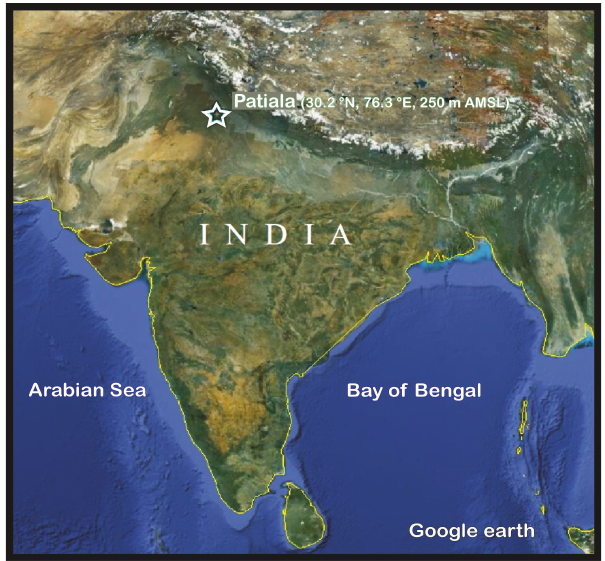
Figure 1: Map showing the sampling site at Patiala in the Indo- Gangetic Plain (IGP) in Northern